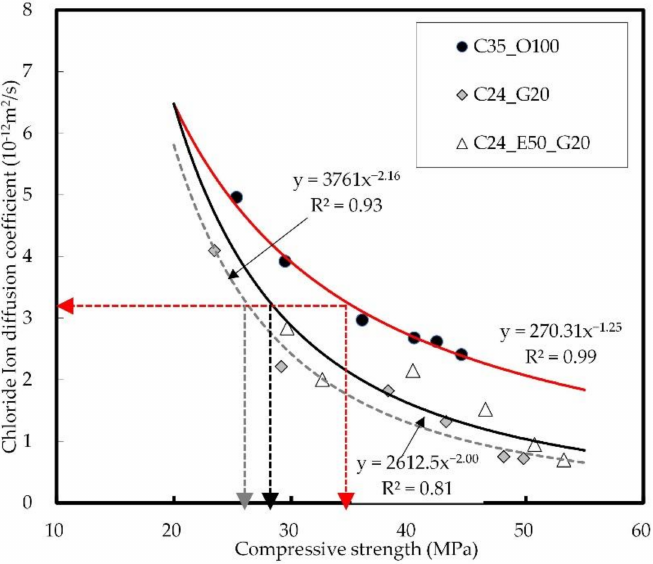
Figure 13. Relation between concrete strength and chloride ion diffusion